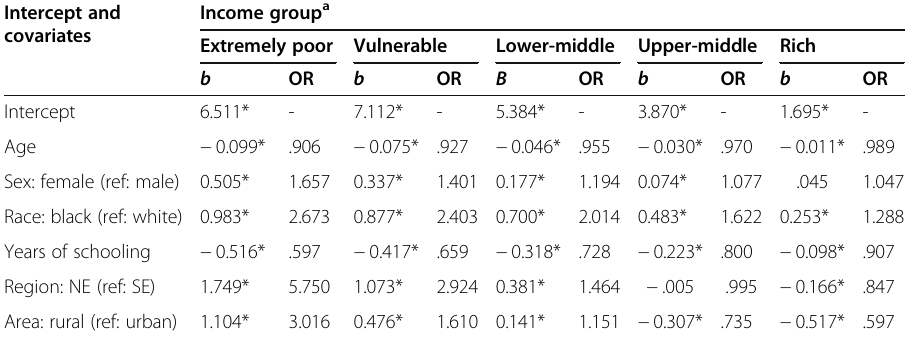
Table 4 Multinomial logistic regression of selected variables on the relative income groups — Northeast (NE) and Southeast (SE) regions, Brazil, 2008 Intercept and Income group a covariates Extremely poor Vulnerable b OR b